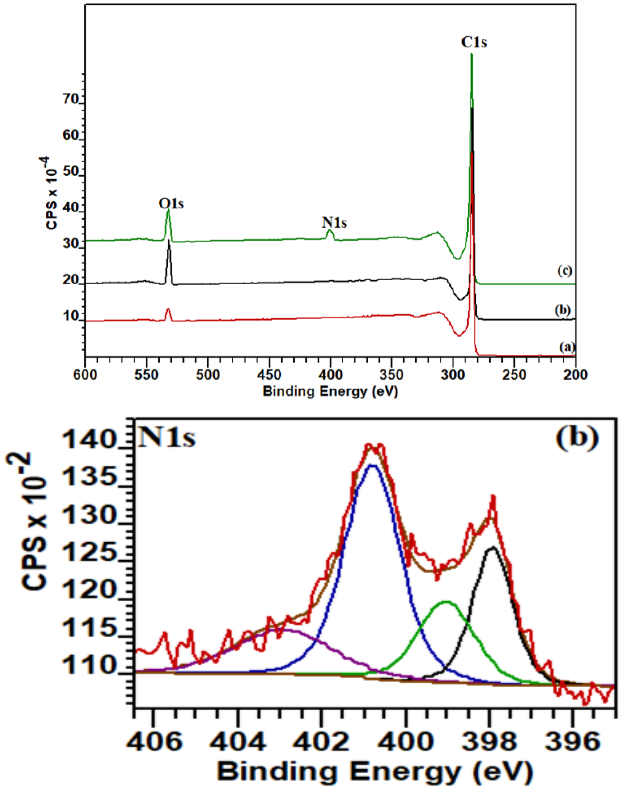
Figure 7. XPS spectra of ( a ) SCSs, HCSs, and NHCSs and ( b ) nitrogen spectrum for the NHCSs.